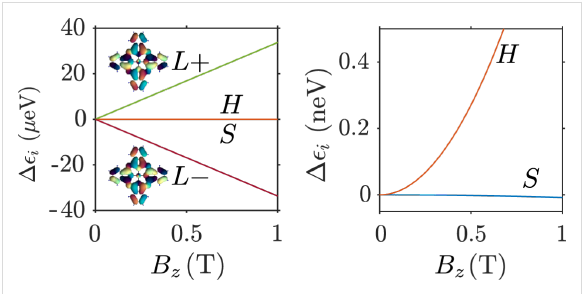
Figure 3: (a) Dependence of the single particle orbital energies on the magnetic field strength. From this, the effective orbital moment of the LUMOs, here depicted in their complex representation, can be extracted as μ orb = 33.7 μ eVT − 1 . The energies of the SOMO and HOMO orbitals depend quadratically on the magnetic field and involve a much lower scale than the LUMOs, as seen in the close-up in panel